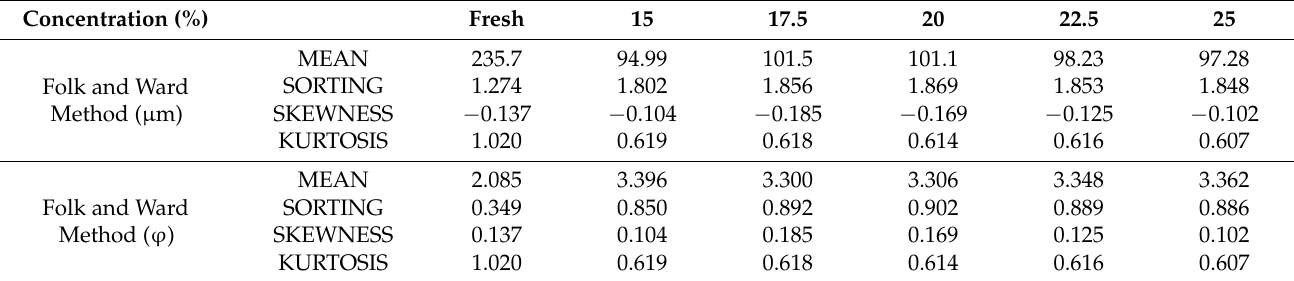
Table 7. Olivine grains distribution